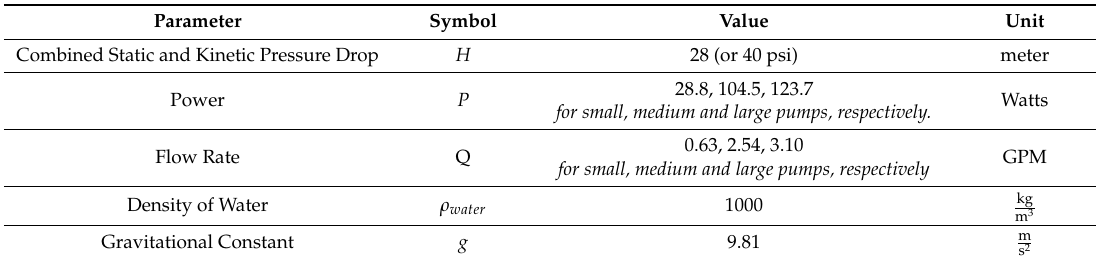
Table 5. Parameters for Equation (11) for a small, medium and large single speed pump specifying parameter, symbol used, value and units